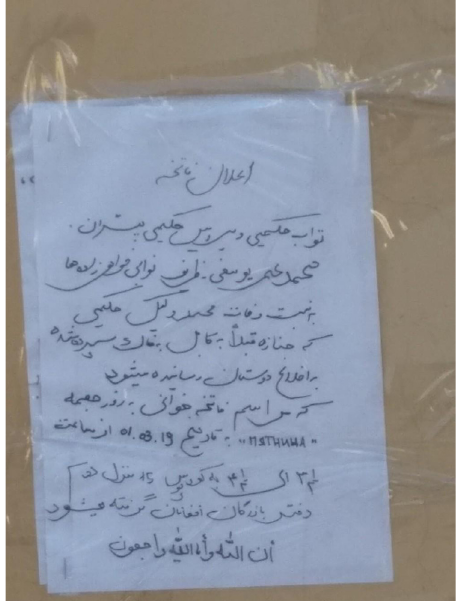
Figure 2: Handwritten announcement in Dari. Apraksin dvor, St. Petersburg, 2019, LinguaSnapp